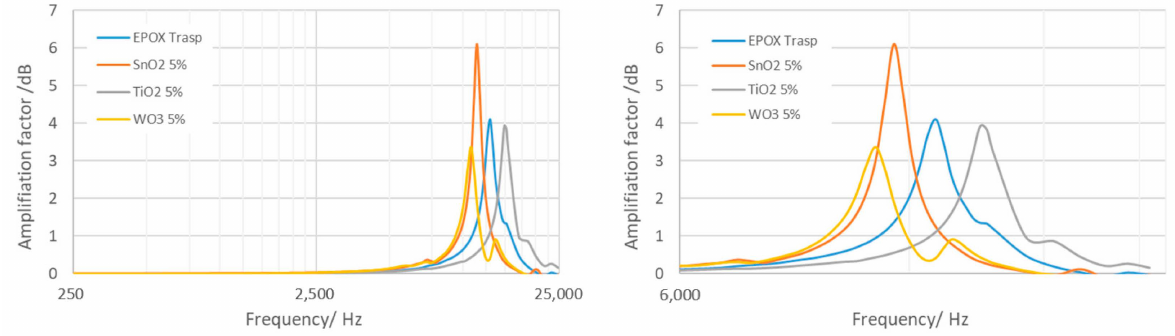
Figure 14. Mechanical behavior of four resins subjected to dynamic excitation. The resonant frequency peaks are clearly identified, as well as the quality factor and amplification factor of each sample.